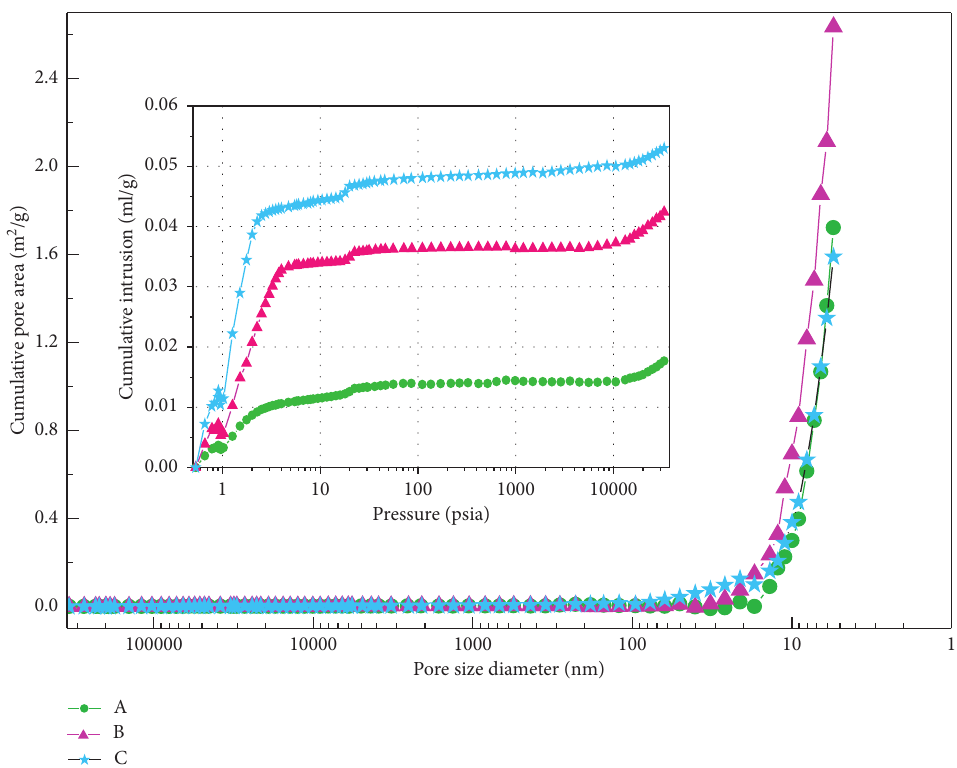
Figure 9: Cumulative pore area and intrusion mercury volume in coal samples: (A) raw coal, (B) coal after heat action, and (C) coal with static blasting material after heat